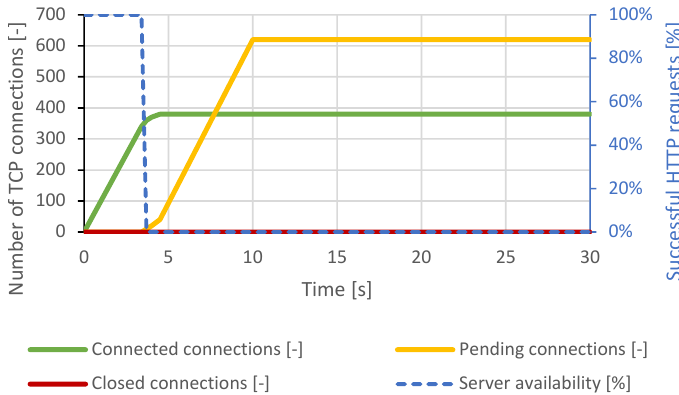
Figure 16. Slowcomm attack against lighttpd server.